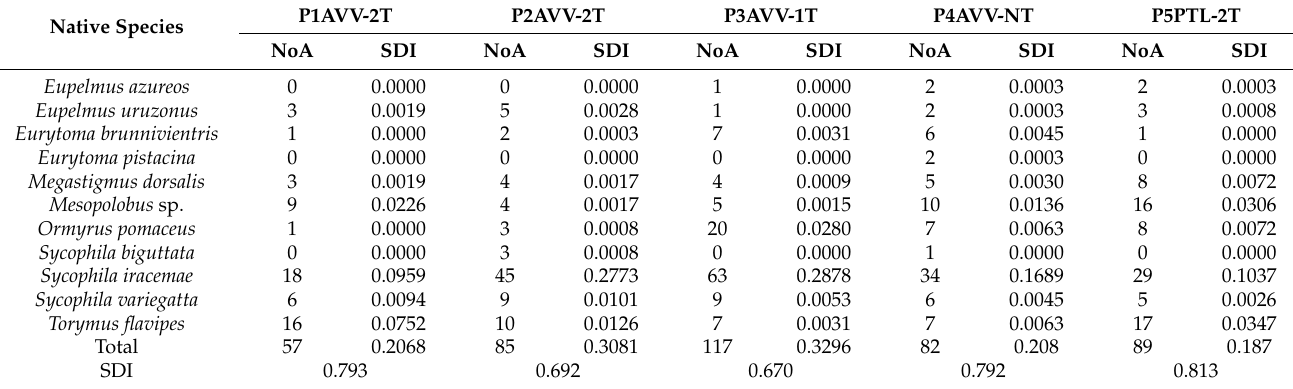
Table 9. Number of adults (NoA) of native parasitoids emerging in orchards in 2018, and the Simpson Diversity Index (SDI) calculated for the five orchards of Minho (P1 to P5), located in Arcos de Valdevez (AVV) and Ponte de Lima (PTL), with one (1T), two (2T) or no treatment (NT) of T. sinensis in